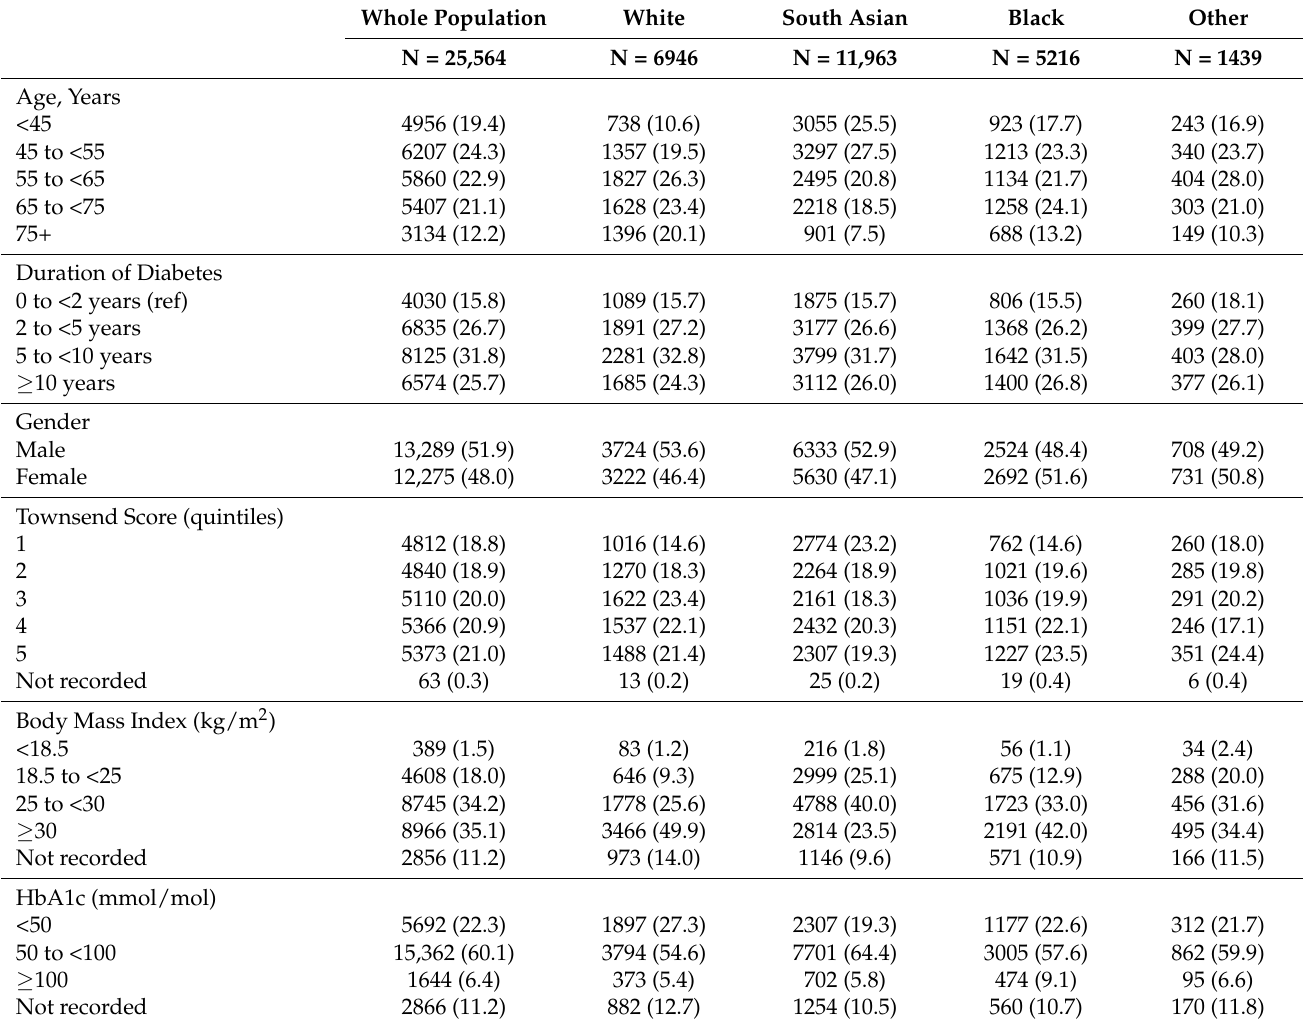
Table 2. Baseline characteristics of the study population—people with known type 2